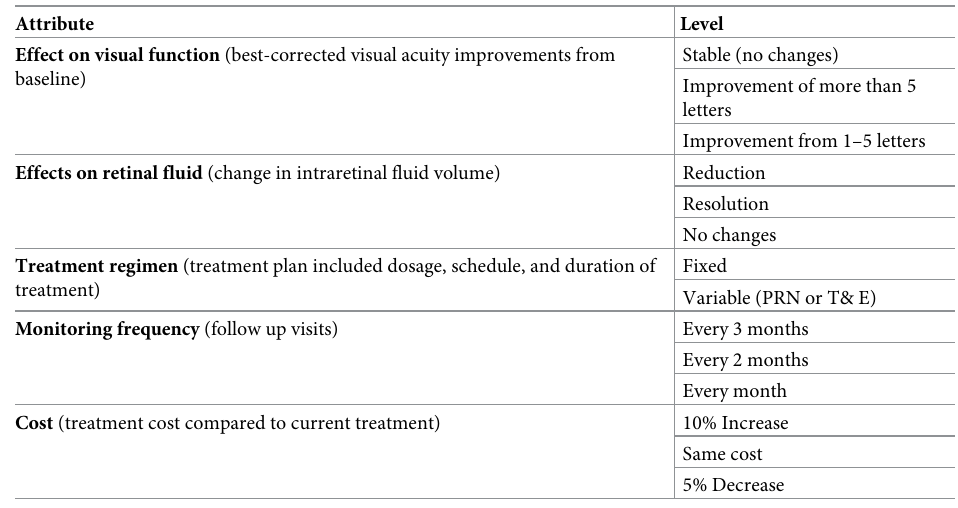
Table 1. Attributes and levels included in the DCE.